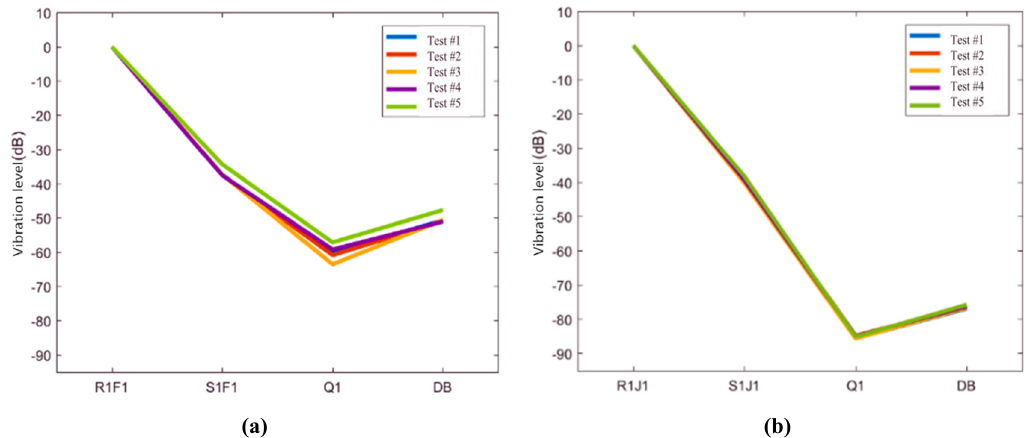
Figure 13. Vertical vibration transfer rules in ballastless tracks. ( a ) Virtual vibration value of the measuring sensors in Condition #1; ( b ) Virtual vibration value of the measuring sensors in Condition #2.